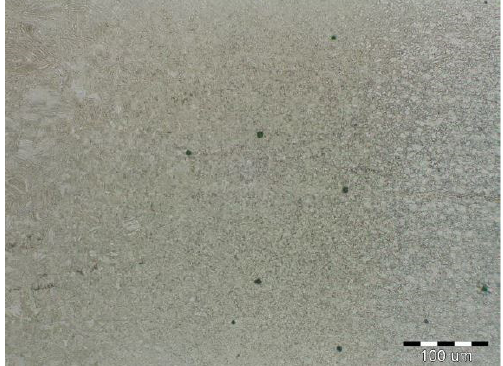
Figure 12. Two-phase microstructure of DP 600 base material.